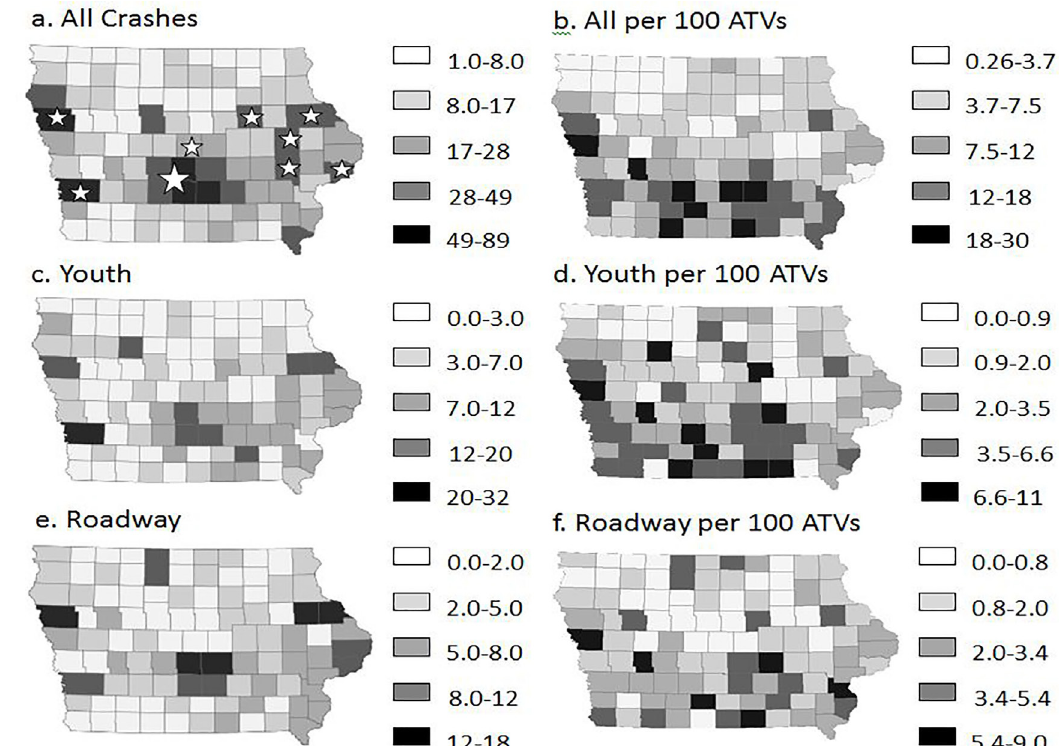
Figure 2. Patterns of all-terrain vehicle (ATV) crashes in the Off-Road Vehicle Crash and Injury Database for the years 2002-2013 by county (n=1,832 crashes). Values in the indicated ranges (automatically selected by ArcGIS for optimal grouping of crashes) are represented using a shaded scale. Crash rates were based on an estimated number of registered vehicles per county and are expressed as crashes per 100 registered ATVs. Panel a, b: Maps show crash number and crash rate for all crashes in each county. Stars represent the largest cities with the larger star representing four cities in the Des Moines metropolitan area. Panel c, d: Maps show crash number and crash rate for crashes in each county involving youth <16 years old. Panel e, f: Maps show crash number and crash rate for roadway crashes in each